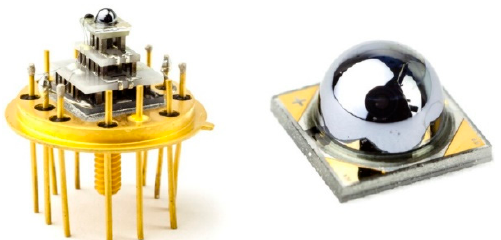
Figure 57. The photodetector assembled on the 3-stage Peltier thermoelectrical cooler and GaAs immersion microlens. The improvement in detectivity reached by hyperhemispherical microlens is proportional to n 2 r , where n r is the GaAs refractive index (after [180]).